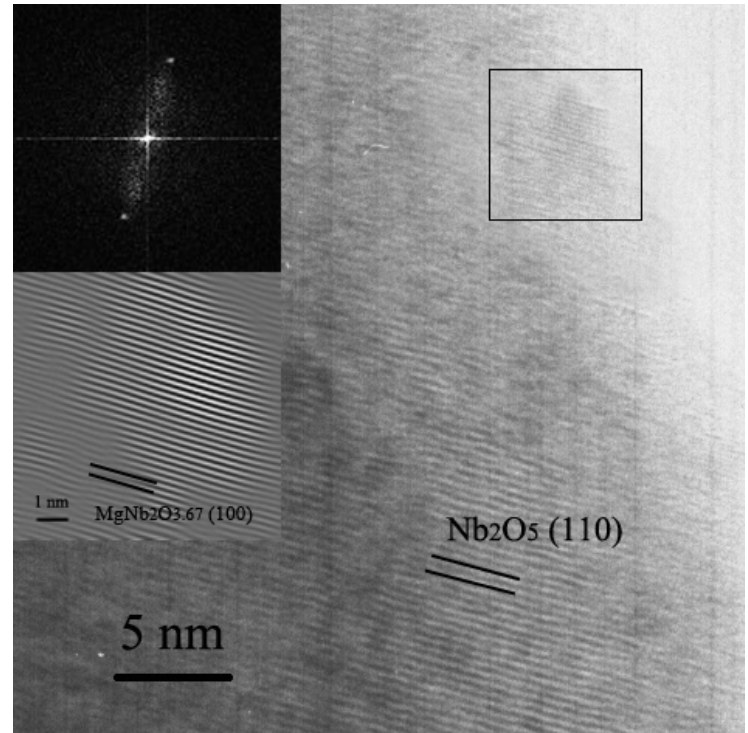
Figure 5. High resolution image of Nb 120 min. The insets are the FFT and IFFT images obtained from the selected area, marked by the